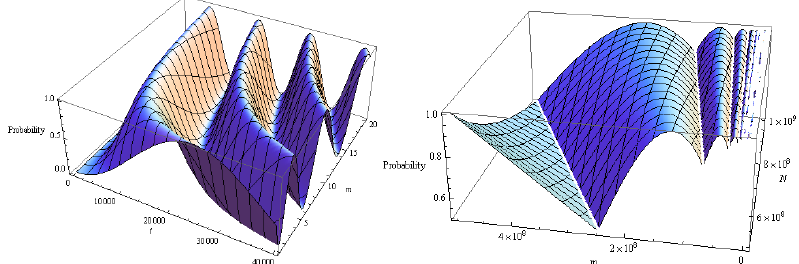
Figure 4: Theoretical estimate of (left) probability of measuring a solution as a function of the number of Grover’s iterations and matching patterns (for N = 10 9 ) and (right) the peak probability for measuring a solution as a function of the number of matching and total number of patterns stored in QuAM. Both estimates assume the special case of uniform initial superposition and errorless quantum